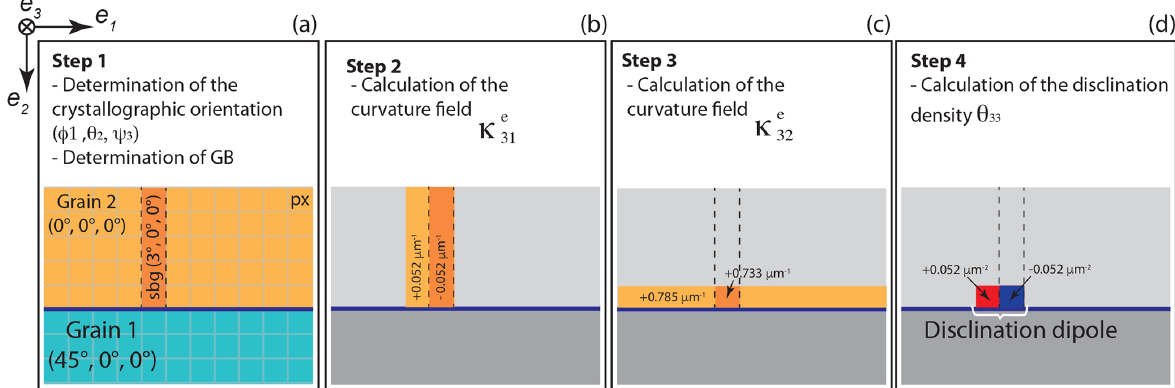
Figure 1. Sketch illustrating an example of the calculation of the wedge disclination θ 33 along a grain boundary. (a) Two grains with orientations given by Euler angles at 45 ◦ , 0 ◦ , 0 ◦ (grain 1) and at 0 ◦ , 0 ◦ , 0 ◦ (grain 2), which define a pure tilt grain boundary (GB) of misorientation > 5 ◦ . A sub-grain is inserted within grain 2 with a disorientation of 3 ◦ around axis e 3 . (b) The field of the K e component of 31 the curvature tensor is derived by one-sided differentiation of field of the ω e component of the elastic rotation vector. (c) The field of the K e 3 32 component of the curvature tensor is derived by forward differentiation of ω e . (d) The density of wedge disclinations θ 33 is derived from 3 forward differentiation of the field of the K e and K e components of the curvature tensor. Redrawn after Fressengeas and Beausir (2018; 31 32 their Fig. 2).